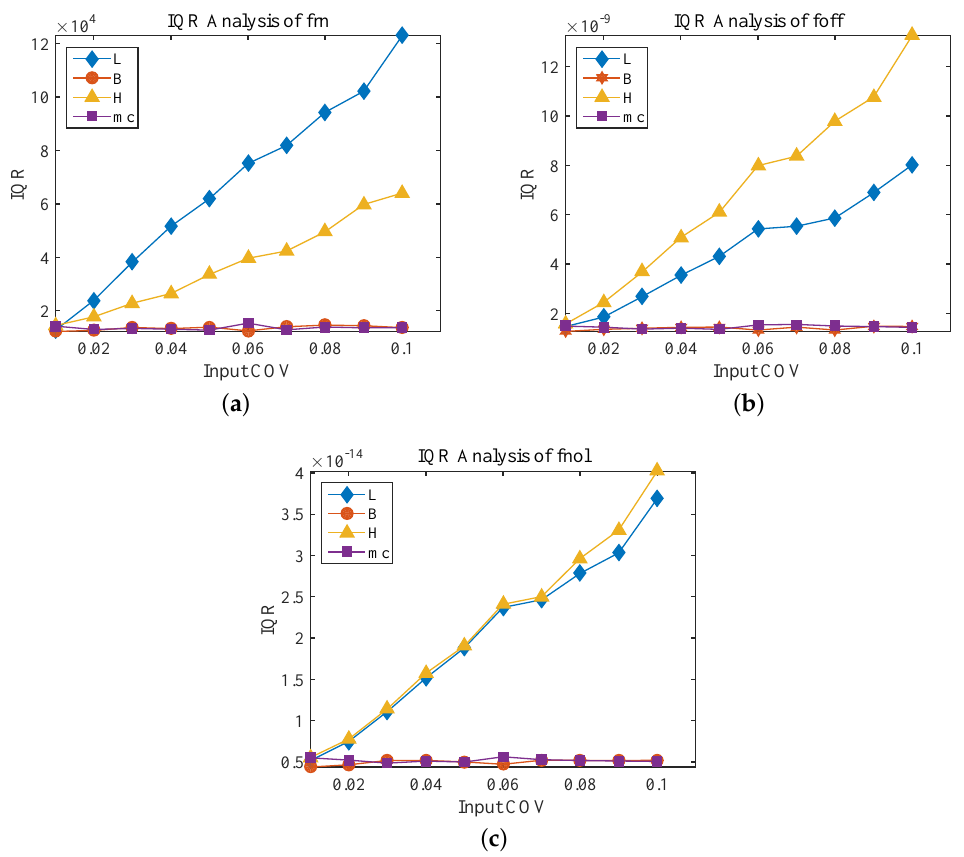
Figure 10. The IQR of output parameters with different COVs of the input parameters. ( a ) IQR Analysis of f rn , ( b ) IQR Analysis of f of f and ( c ) IQR Analysis of f nol